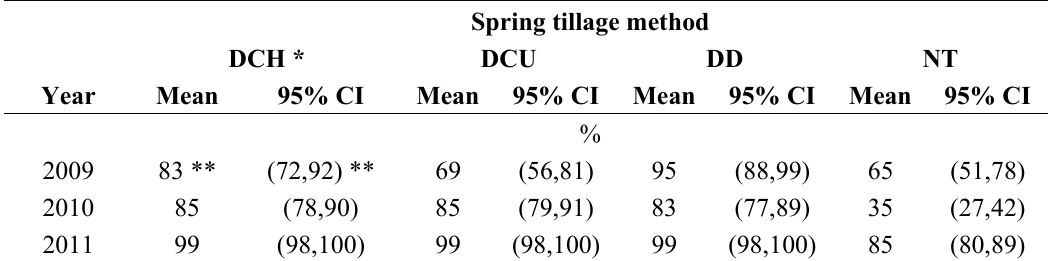
Table 5. Year by spring tillage method interaction means for Palmer amaranth control 6 WAA *; data combined over soil inversion and cover crops.